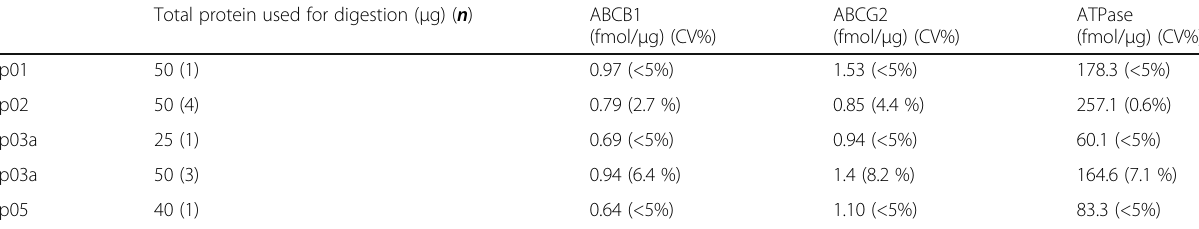
For lower limits of quantification, see [27] %CV, % coefficient of variation: n = digestion replicate, each digested sample was injected three times. Quantification CV% <5% is the variation between transitions and results from three injections (for the three samples digested once and injected three times) a Two different samples collected during